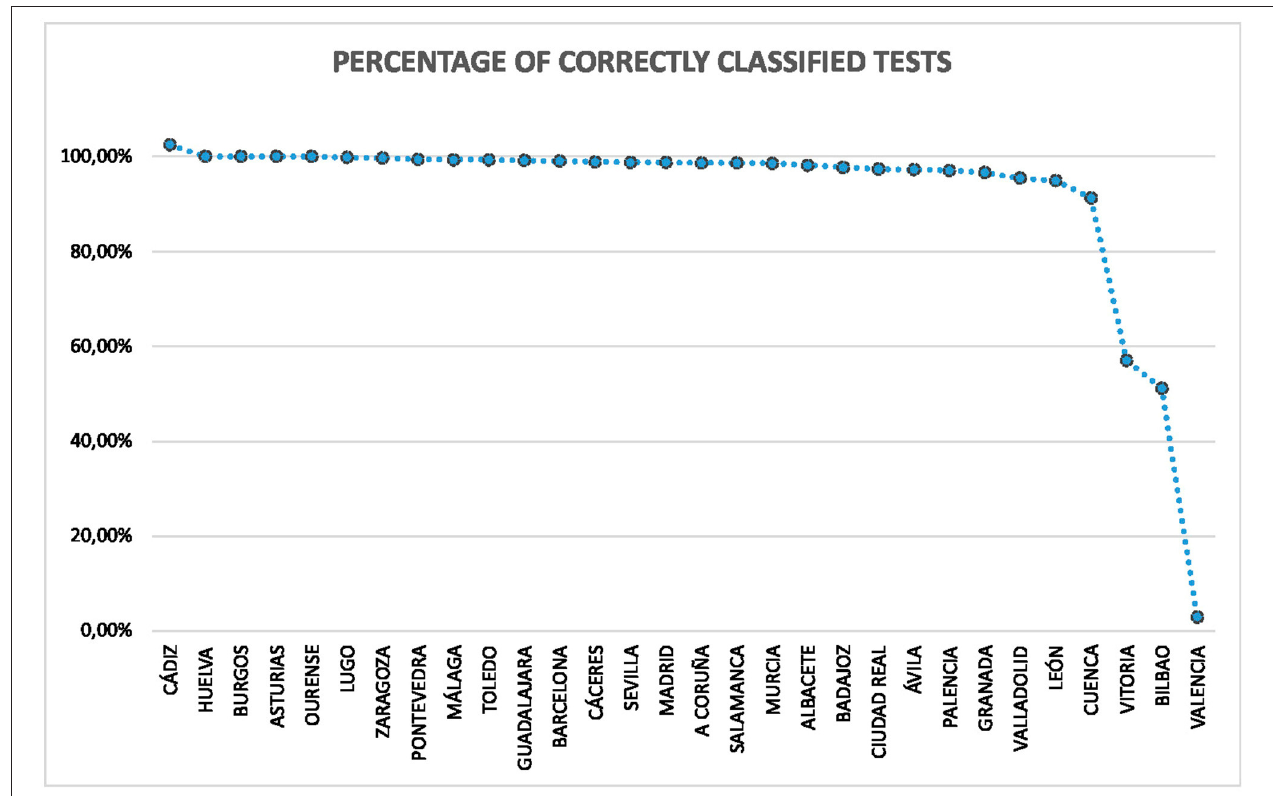
FIGURE 2 | Percentage of correct tests by